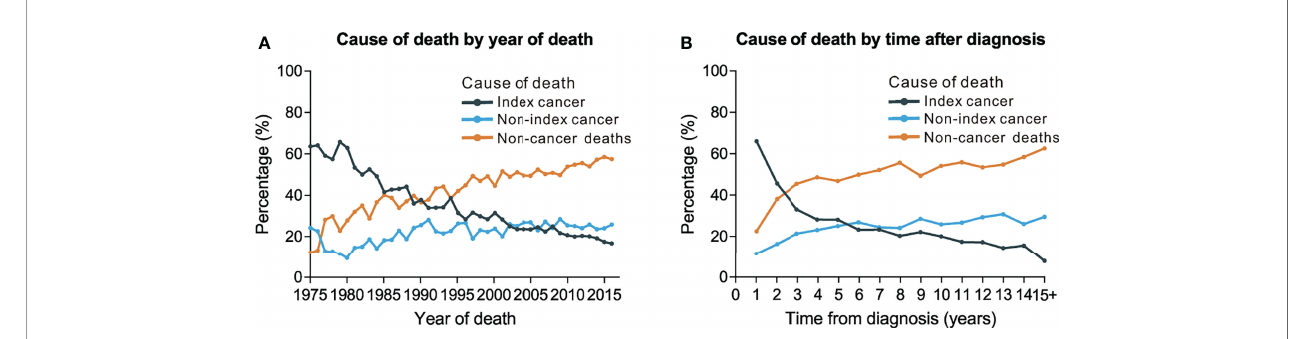
FIGURE 1 | Trends of cause of death by year of death and time after diagnosis. (A) Trends of cause of death by year of death among patients with thyroid cancer. (B) Trends of cause of death by time after diagnosis.